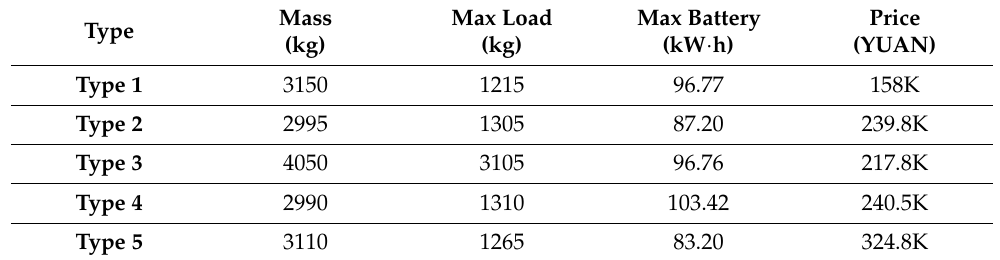
Table 6. Attributes of EVs.